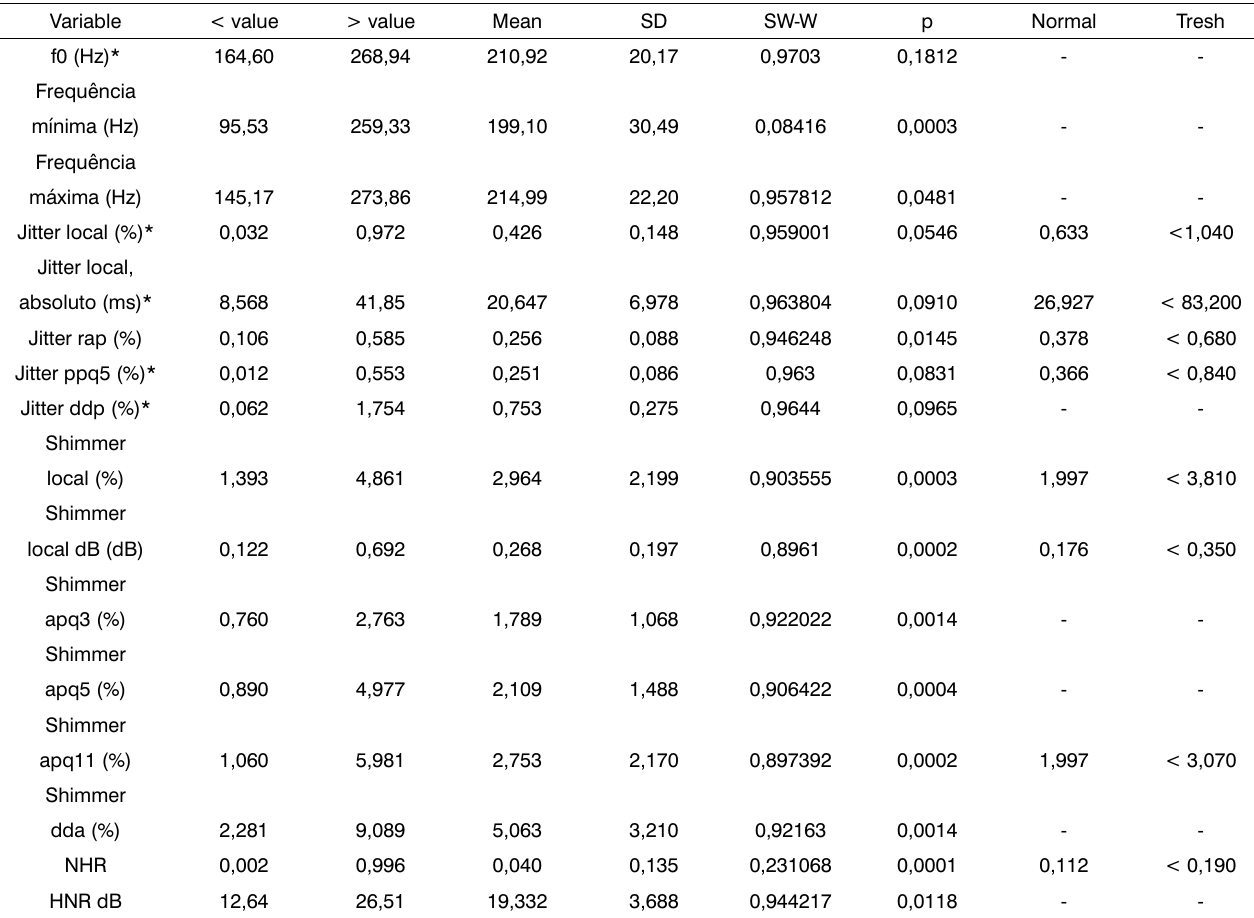
Table 3. Results of acoustic voice